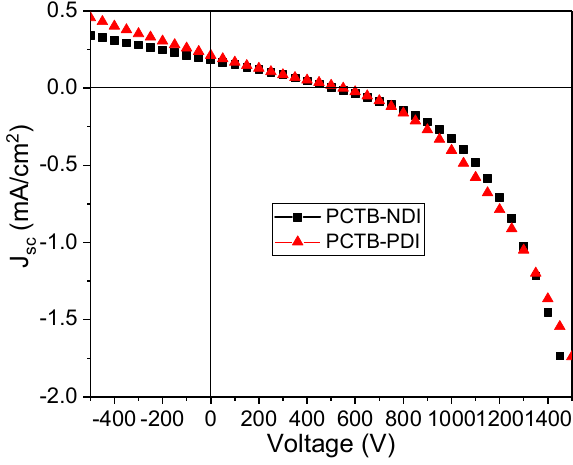
Figure 4. IV-curves of photovoltaic devices with PCTB-NDI or PCTB-PDI as one-component BHJ.